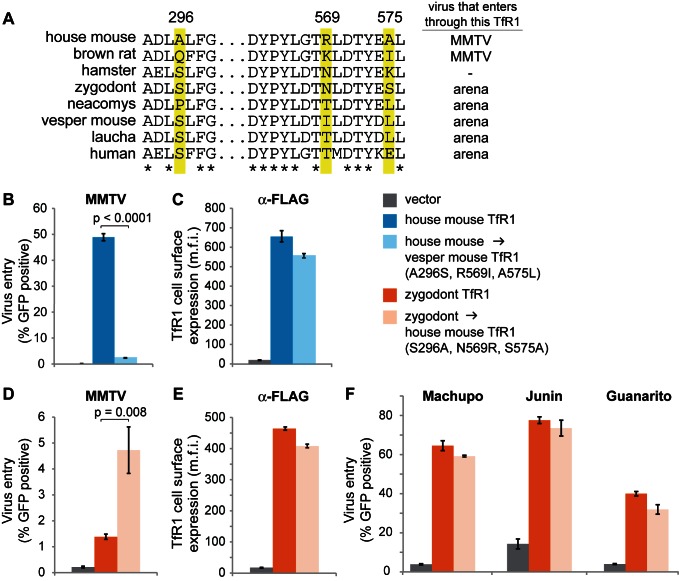
Mutations at sites of positive selection alter MMTV entry through TfR1.(A) A partial TfR1 sequence alignment shows the three residue positions under positive selection (highlighted in yellow) located in the MMTV binding region. Asterisks indicate completely conserved residue positions, while positions under positive selection are highly variable. The viruses that have been previously shown to enter cells via each of these receptors are also summarized (although in the case of brown rat, cellular entry of MMTV via the rat TfR1 does not lead to productive infection [13], consistent with TfR1 usage being a necessary but not sufficient determinant of host range in the wild). In the remaining panels, amino acids are swapped between the species indicated at these three positions under positive selection. In one case (blue graphs), these three positions in the house mouse TfR1 were altered to encode the amino acids found in the vesper mouse TfR1. In the second case (orange graphs), these three positions in the zygodont TfR1 were altered to encode the amino acids found in the house mouse TfR1. (B and D) MDCK cells stably expressing the indicated TfR1-FLAG were infected with GFP-encoding retroviral vectors pseudotyped with the surface glycoprotein of MMTV. Virus entry was scored by measuring the percentage of GFP positive cells using flow cytometry. (C and E) Cell surface expression of TfR1 (mean fluorescent intensity) measured on live cells with a fluorescently labeled α-FLAG antibody. (F) Cellular entry of retroviral vectors pseudotyped with the surface glycoproteins of three different arenaviruses (Machupo, Junin, and Guanarito). In all experiments, three replicates were performed and error bars indicate one standard deviation.